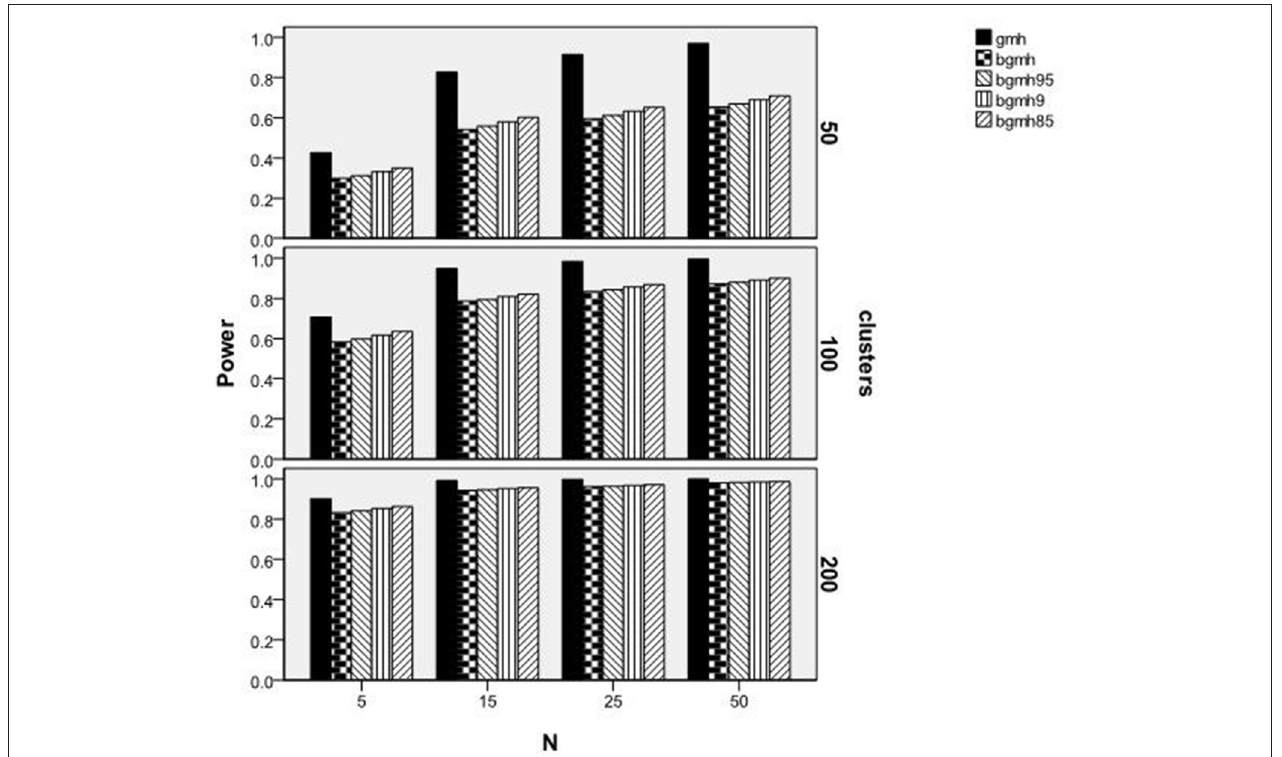
FIGURE 4 | Power by method, number of clusters, and sample size per